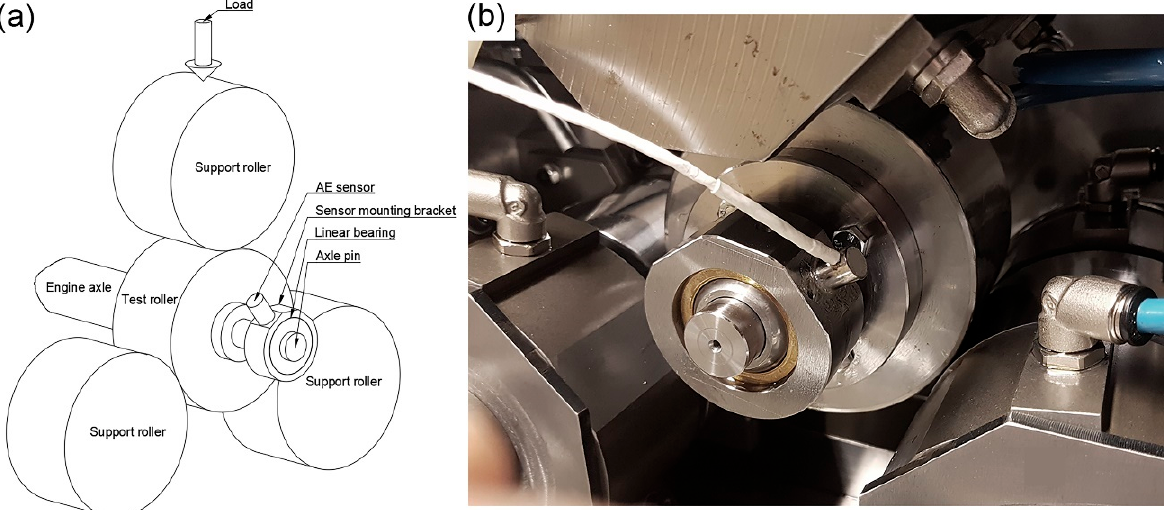
Figure 1. ( a ) Schematics and ( b ) the photographic image of the part of the test rig showing the test roller, the support rollers, and the AE sensor mounting.